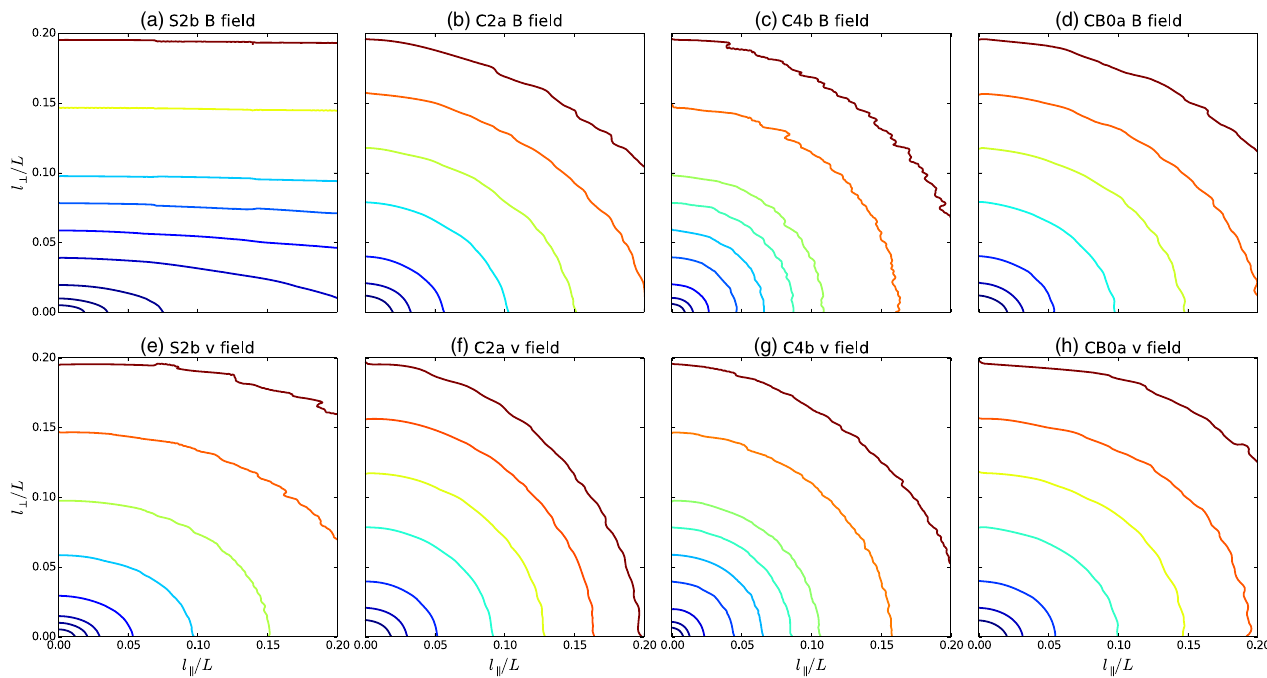
FIG. 12. The 2D structure functions for the fast mode for magnetic fields (top panels) and velocity fields (bottom panels) for the simulations S2b(a,e), C2a(b,f), C4b(c,g), and CB0a(d,h). They seem to be isotropic for the cases C2a, C4b, and CB0a, while for S2b, there seems to be some